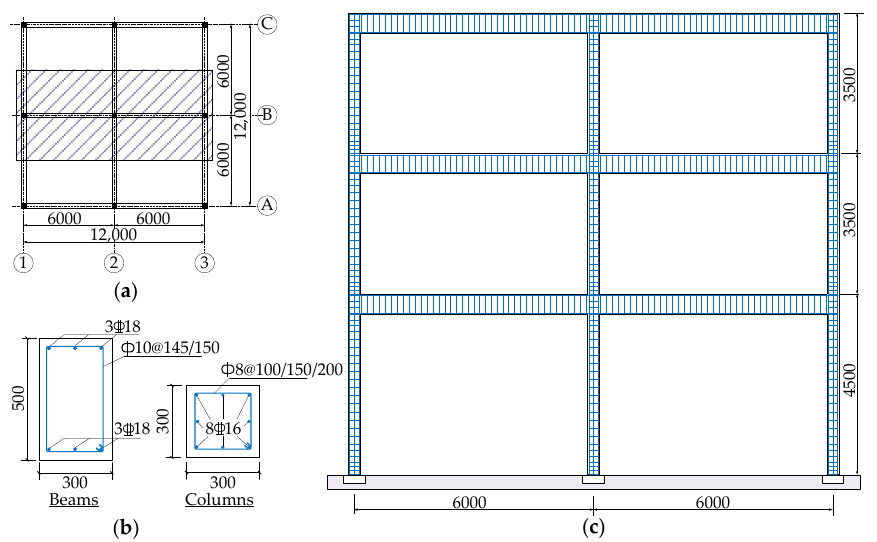
Figure 2. Geometries and reinforcement details for RC frame (all dimensions in mm): ( a ) plan view; ( b ) reinforcement details of the beam and column section; ( c ) elevation view.